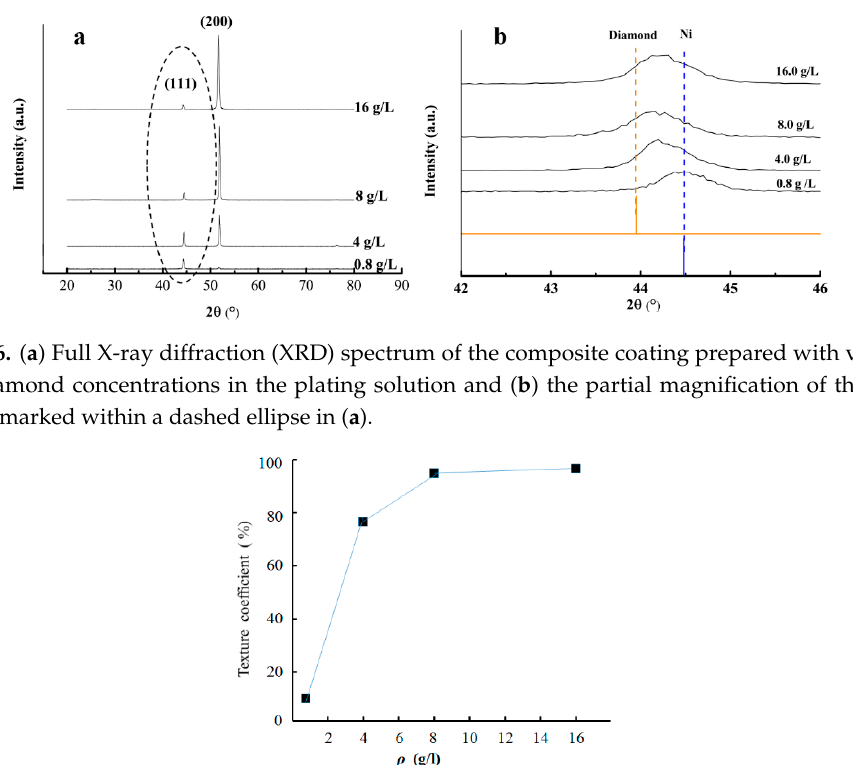
( d ) Figure 5. Scanning electron microscopy (SEM) images of the composite coating plated at various concentrations of nanodiamond particles in the plating solution from 0.8 to 16.0 g/L: ( a ) 0.8 g/L, ( b ) 4.0 g/L, ( c ) 8.0 g/L, and ( d ) 16.0 g/L. 3.2.2. Phase Structure Figure 6 presents the X-ray diffraction (XRD) patterns of the plated deposits and the texture coefficients of the (200) crystal face at the current density of 3.0 A/dm 2 and with various nanodiamond concentrations in the plating solution. According to Figure 6a, no new phase was formed following the addition of nanodiamond particles, whereas the diffraction intensity of the various crystal faces of the composite coating was significantly changed. The diffraction peak intensity of the (200) crystal orientation in the composite coating gradually increased as the nanodiamond concentration increased, indicating that the addition of nanodiamond particles led to the preferential orientation of the composite coating along the (200) crystal orientation. Figure 6b shows the partial magnification of the XRD spectra marked within a dashed ellipse in Figure 6a, which demonstrates the existence of nanodiamond particles. It can be clearly observed that when the concentration of the nanodiamond particles in the plating solution varies from 0.8 g/L to 16.0 g/L, all the (111) peaks of the composite coatings deviate from the (111) peak of standard nickel. When the concentration of the nanodiamond particles in the plating solution was 8.0 g/L, the peak